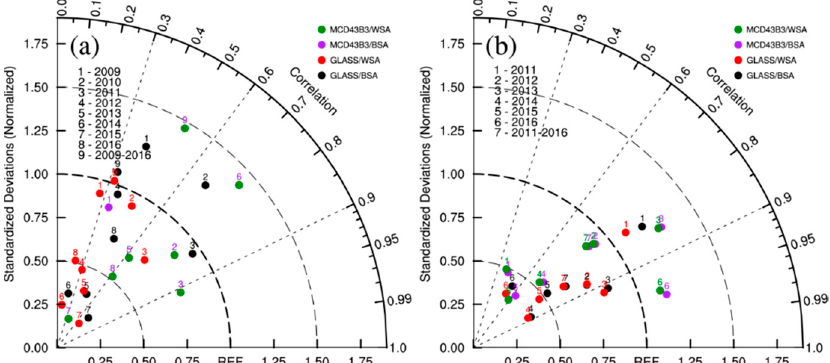
Figure 3. Taylor diagrams of the statistics of the 8-day average albedo of surface albedo products and ground-based observation at ( a ) Maqu and ( b ) Maduo sites. Remote Sens. 2020 , 12 , x FOR PEER REVIEW 9 of 20